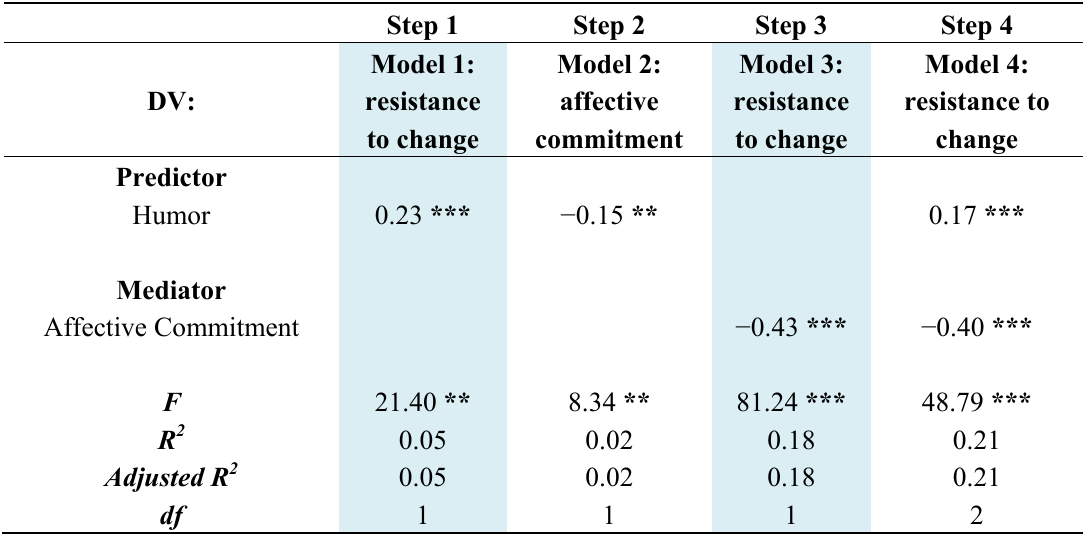
Table 1. Mediation analysis (affective commitment) a